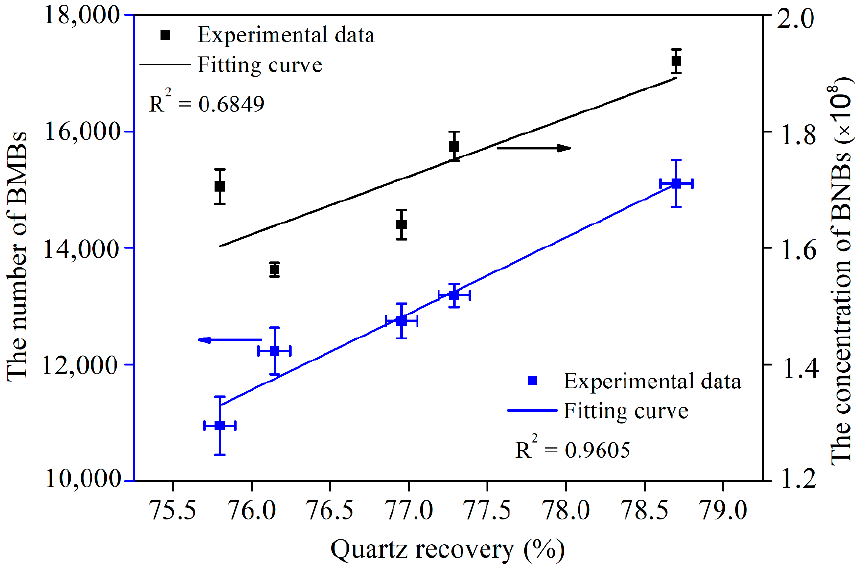
Figure 13. Number of BMBs (>1 μ m) and concentration of BNBs as functions of flotation recovery (under different aeration rates).